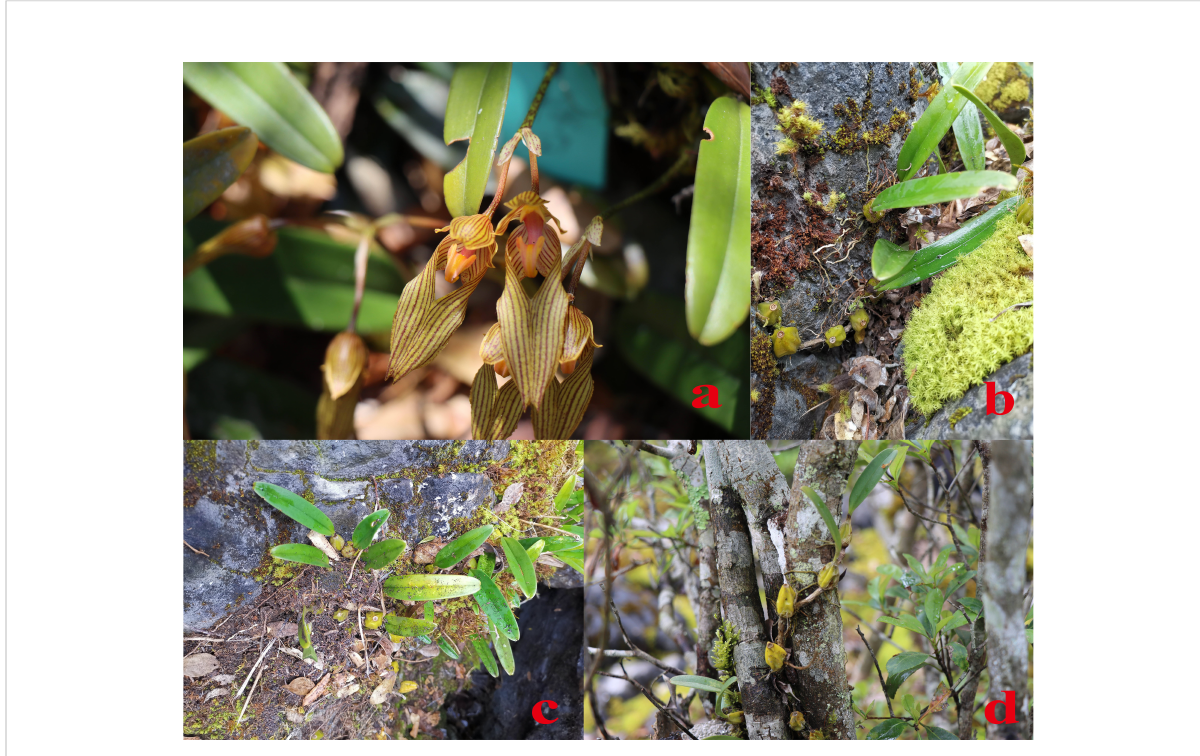
FIGURE 1 Growth situation of B tianguii . [ (A) : B tianguii ; (B) : Roots attached to stone walls; (C) : Roots attached to humus soil; (D) : Roots attached to the